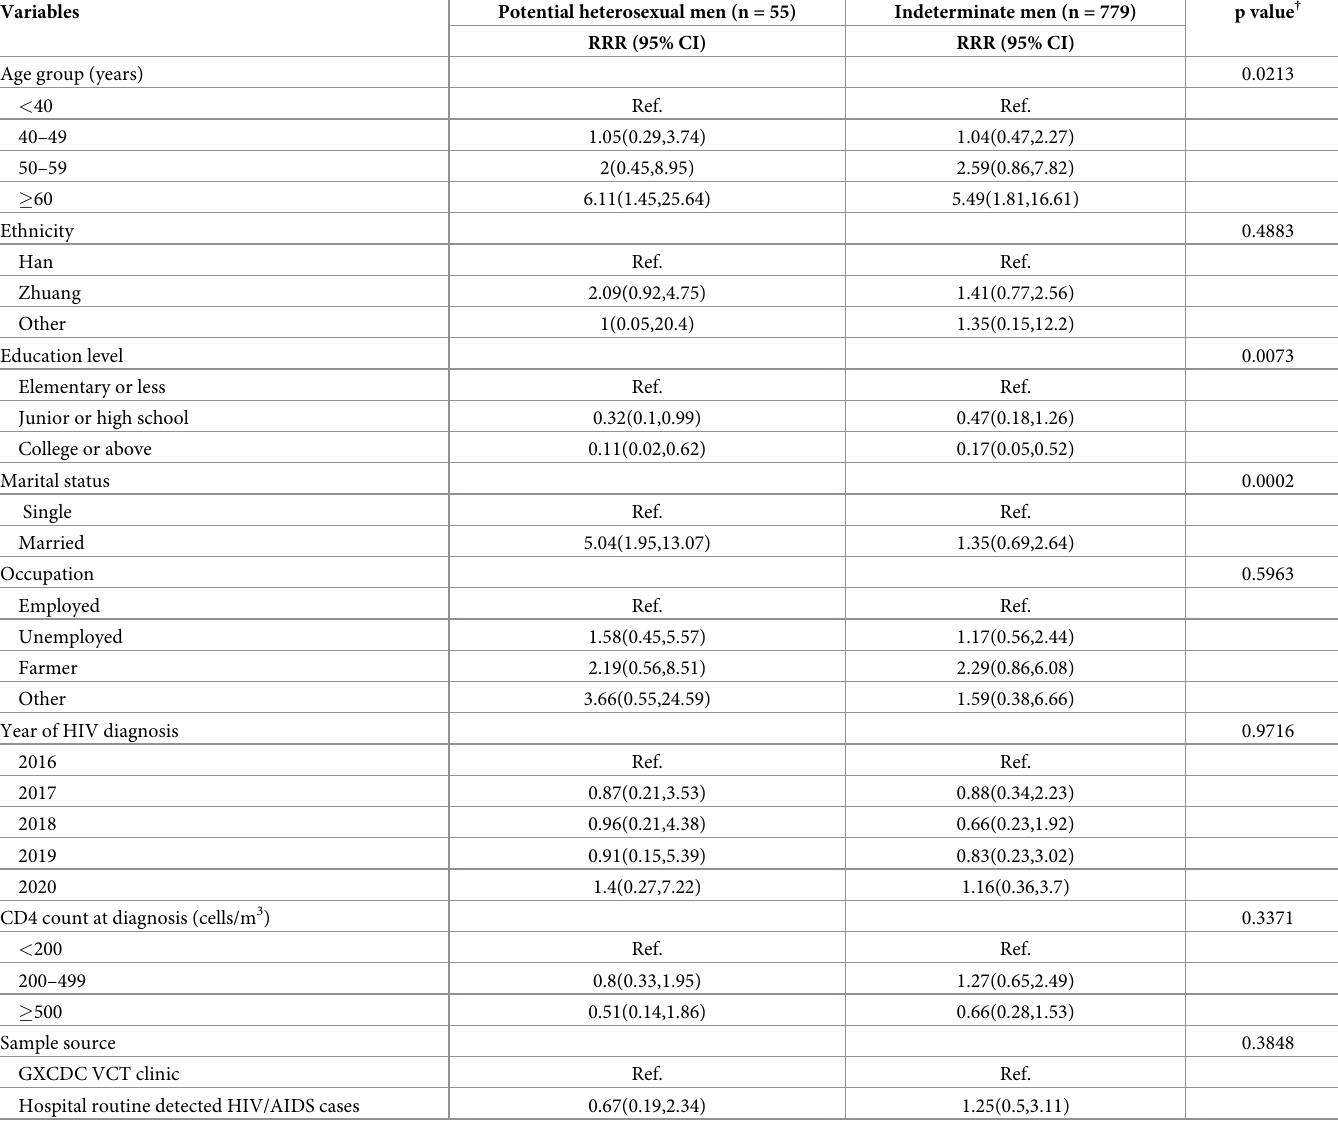
Table 4. Multinomial logistic regression analysis comparing potential heterosexual and indeterminate men with pnMSM (n =